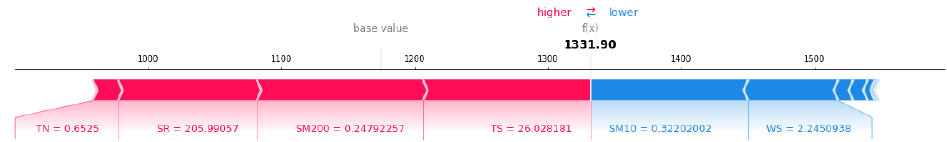
Figure 2. Decomposed SHAP values for the prediction of an example individual pixel. The base value indicates the averaged output of the predictions. f(x) indicates the specific prediction of this sample. Features that increase the value of the prediction are shown in red; those that lower the prediction value are shown in